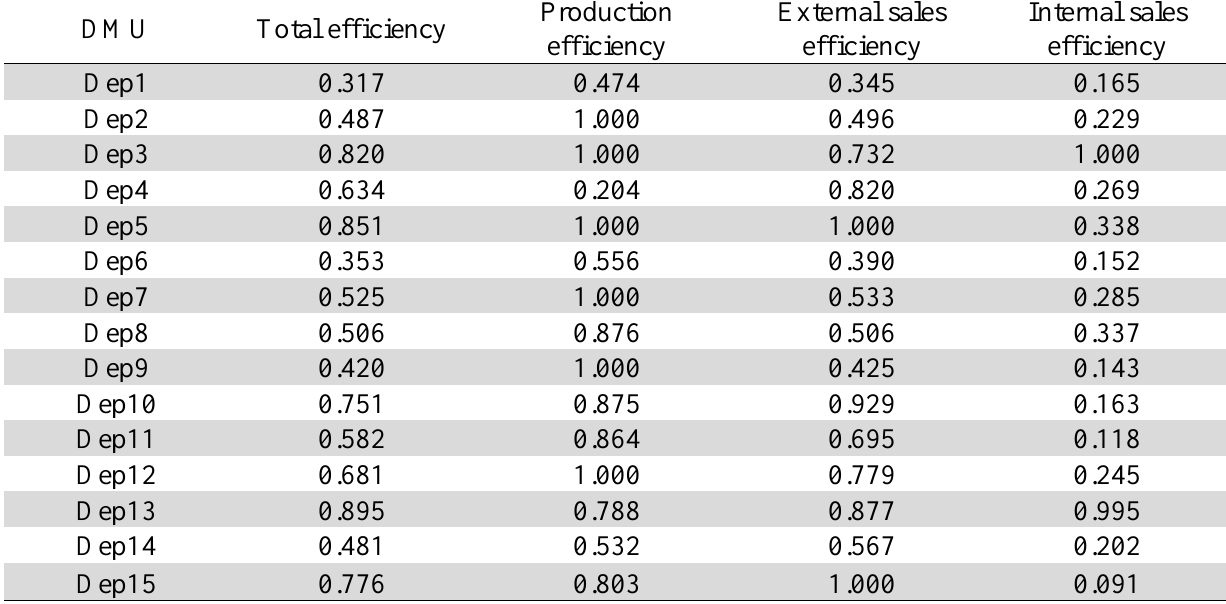
Results of efficiency